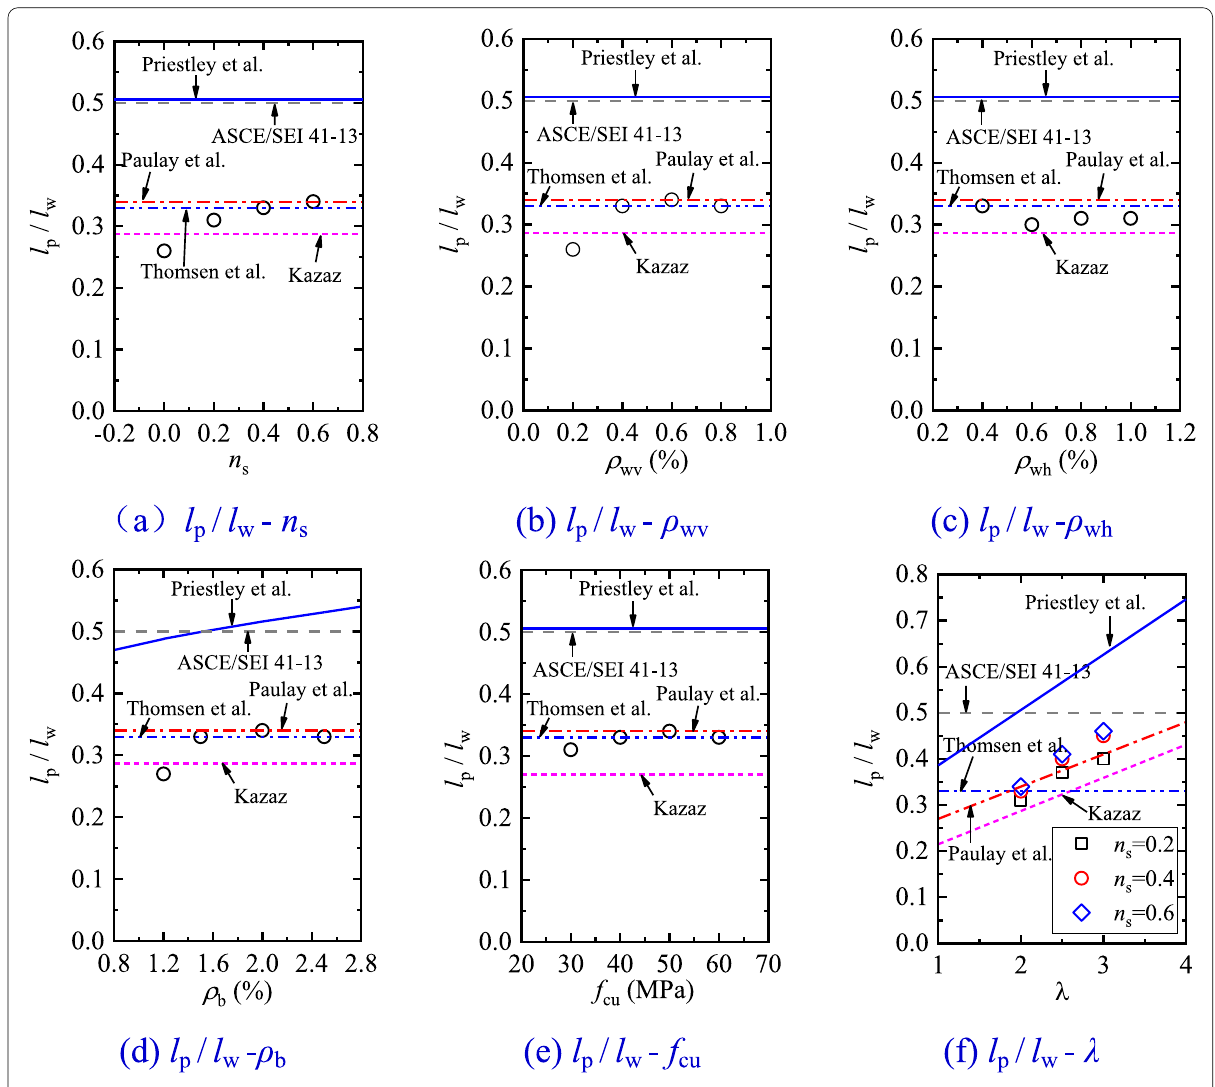
Fig. 27 Equivalent plastic hinge length l p of RC walls under coupled axial